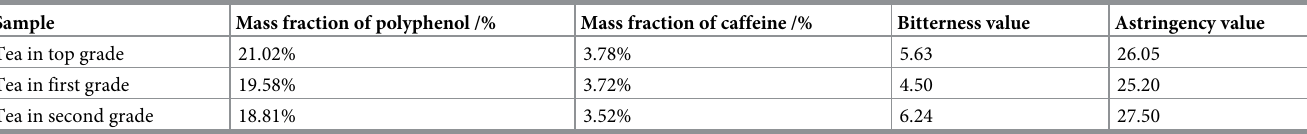
Table 2. Chemical composition and taste analysis of Xinyang Maojian tea. Sample